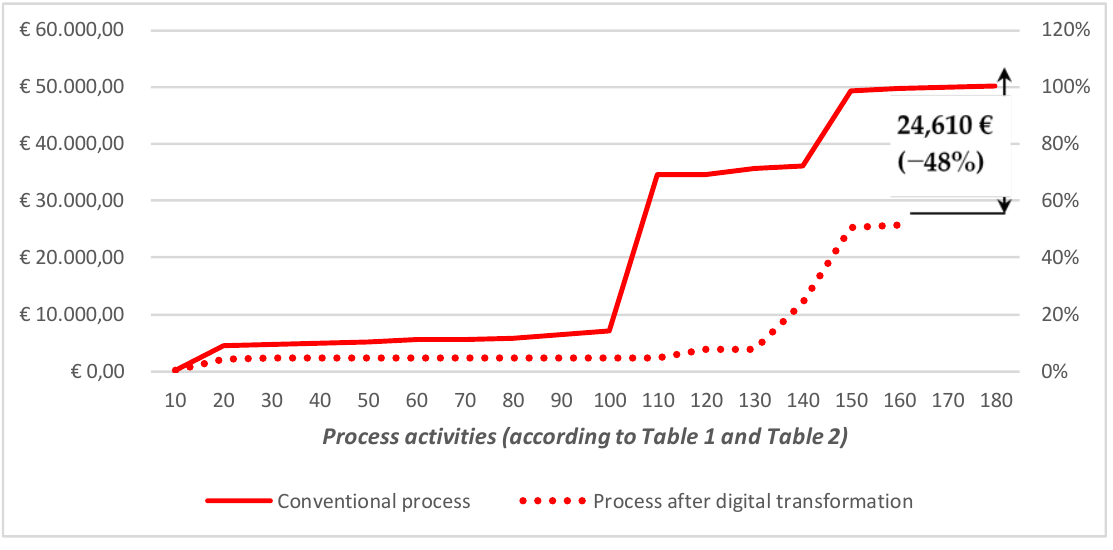
Figure 1. Costs comparison of the conventional process and the process after digital transformation.